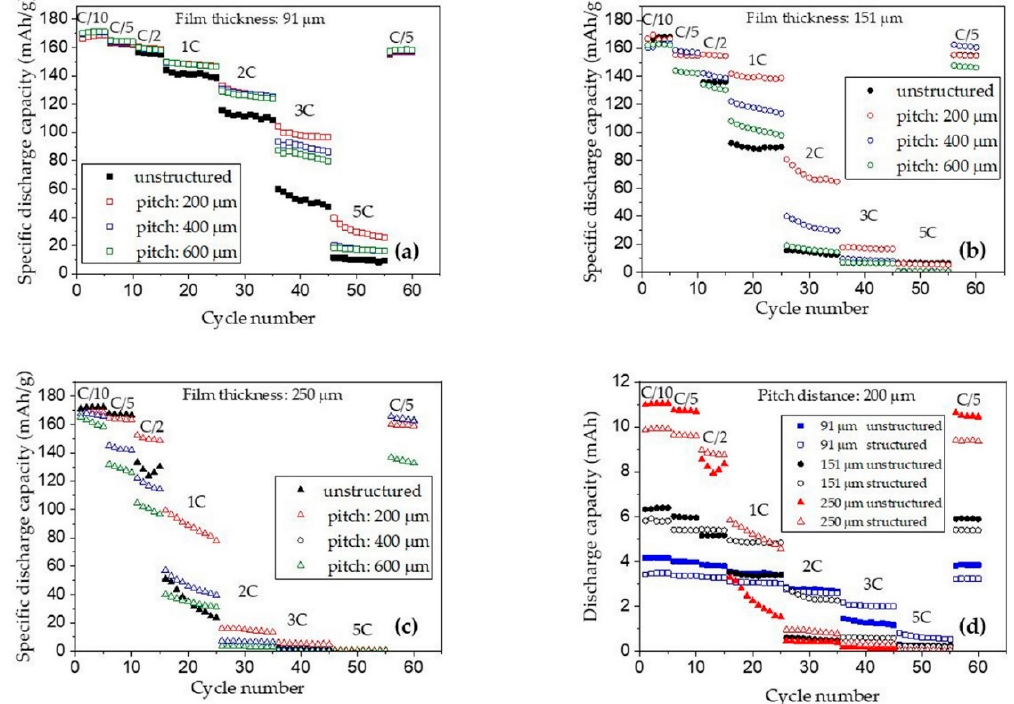
Figure 4. Specific discharge capacity of cells containing ( a ) 91 µm, ( b ) 151 µm, and ( c ) 250 µm thick electrodes; and ( d ) the discharge capacity of cells with different cathode thicknesses and 200 µm pitch distance at different C-rates.